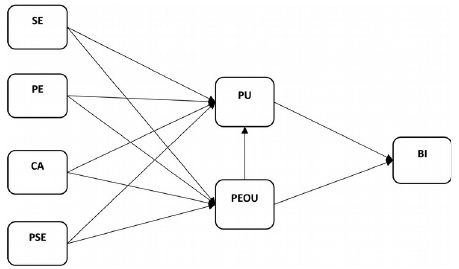
Figure 1. The conceptual